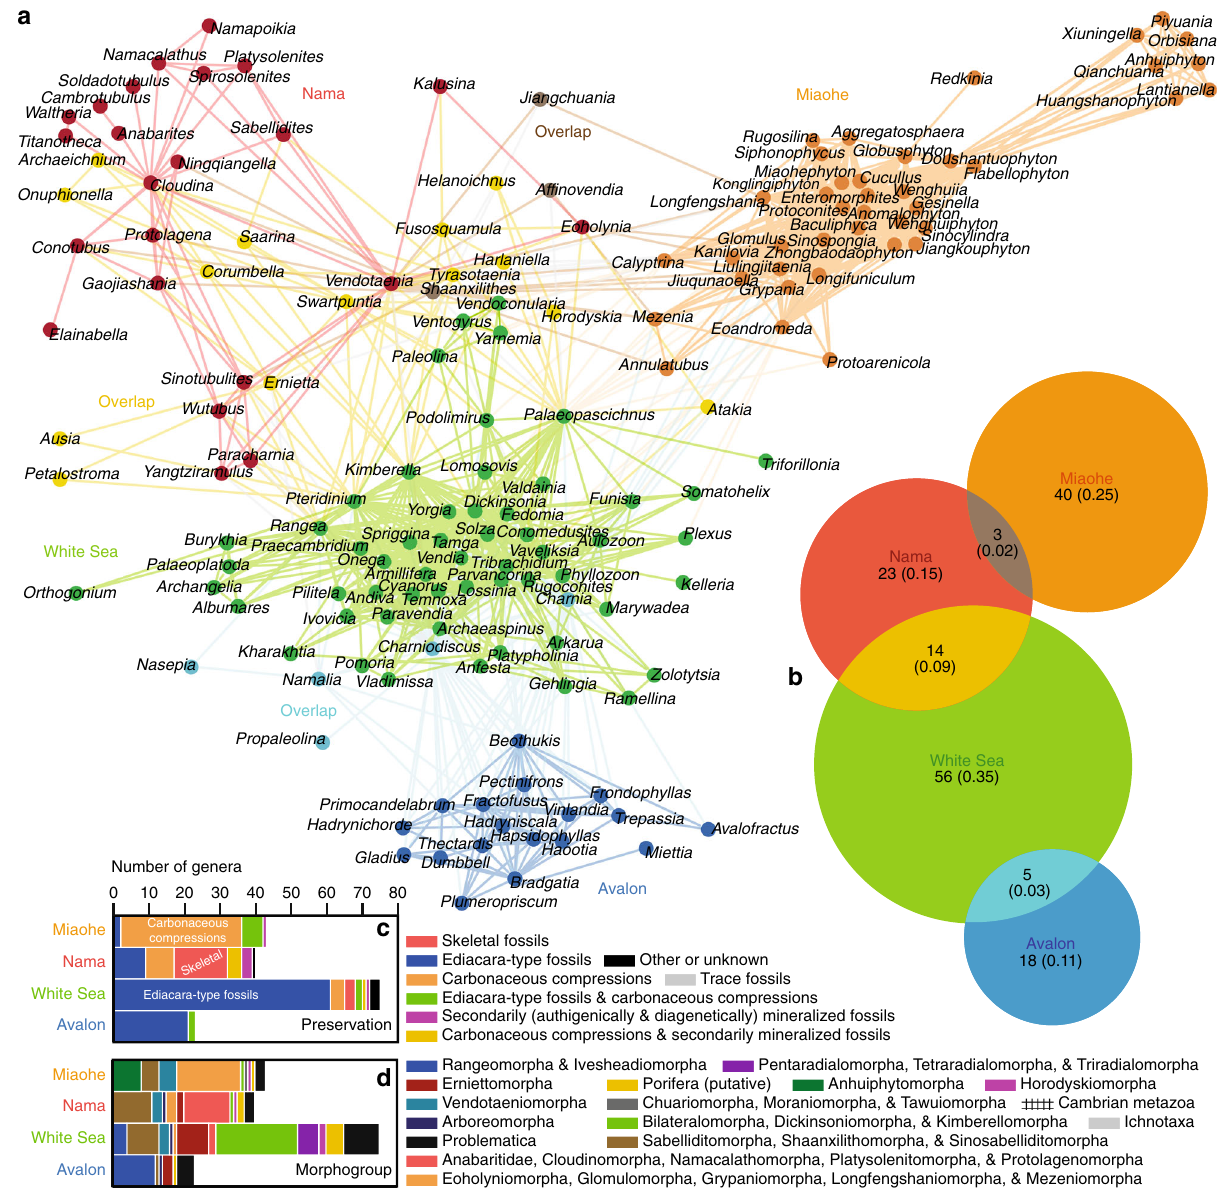
Fig. 2 Unipartite network of Ediacaran macrofossil genera. a Network graph. Two genera are linked if those taxa cooccur at any fossil collection point in the dataset. Colors indicate modules identi fi ed using the COPRA community-detection algorithm ( v = 5). According to randomization testing, this community structure is statistically signi fi cant (Supplementary Fig. 9; Q = 0.82, P < 0.01, Z = 7.700). All genera fall into four modules: the Avalon (blue), White Sea (green), Miaohe (orange), and Nama (red) clusters (Fig. 1; Supplementary Figs. 2 – 4). b Venn diagram illustrating module overlap. Areas of circles correspond to their relative numbers of genera, numbers are counts of taxa, and values in parentheses are proportions. c , d Stacked bar graphs showing numbers of genera in the modules and their preservational modes ( c ) and morphogroups ( d ). Source data are provided as a Source Data fi